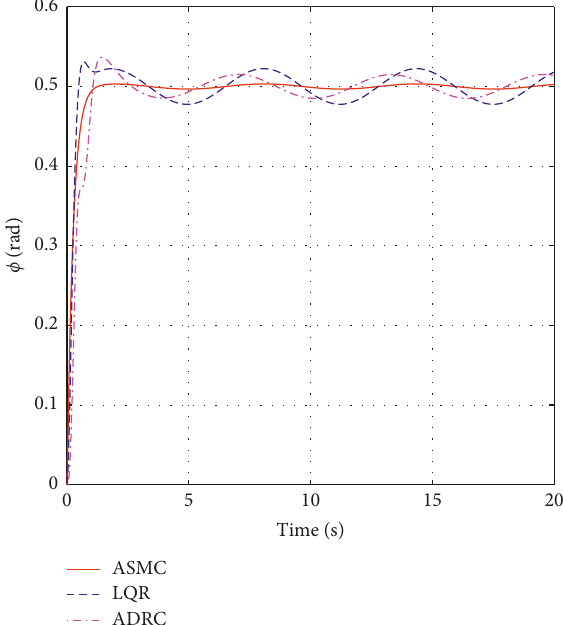
Figure 7: The tracking performance of roll